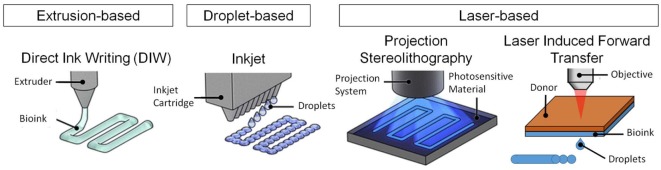
3D bioprinting techniques for bioprinting of tissues and organs. Figure reproduced with permission from Miller and Burdick (2016). Copyright 2016, American Chemical Society.